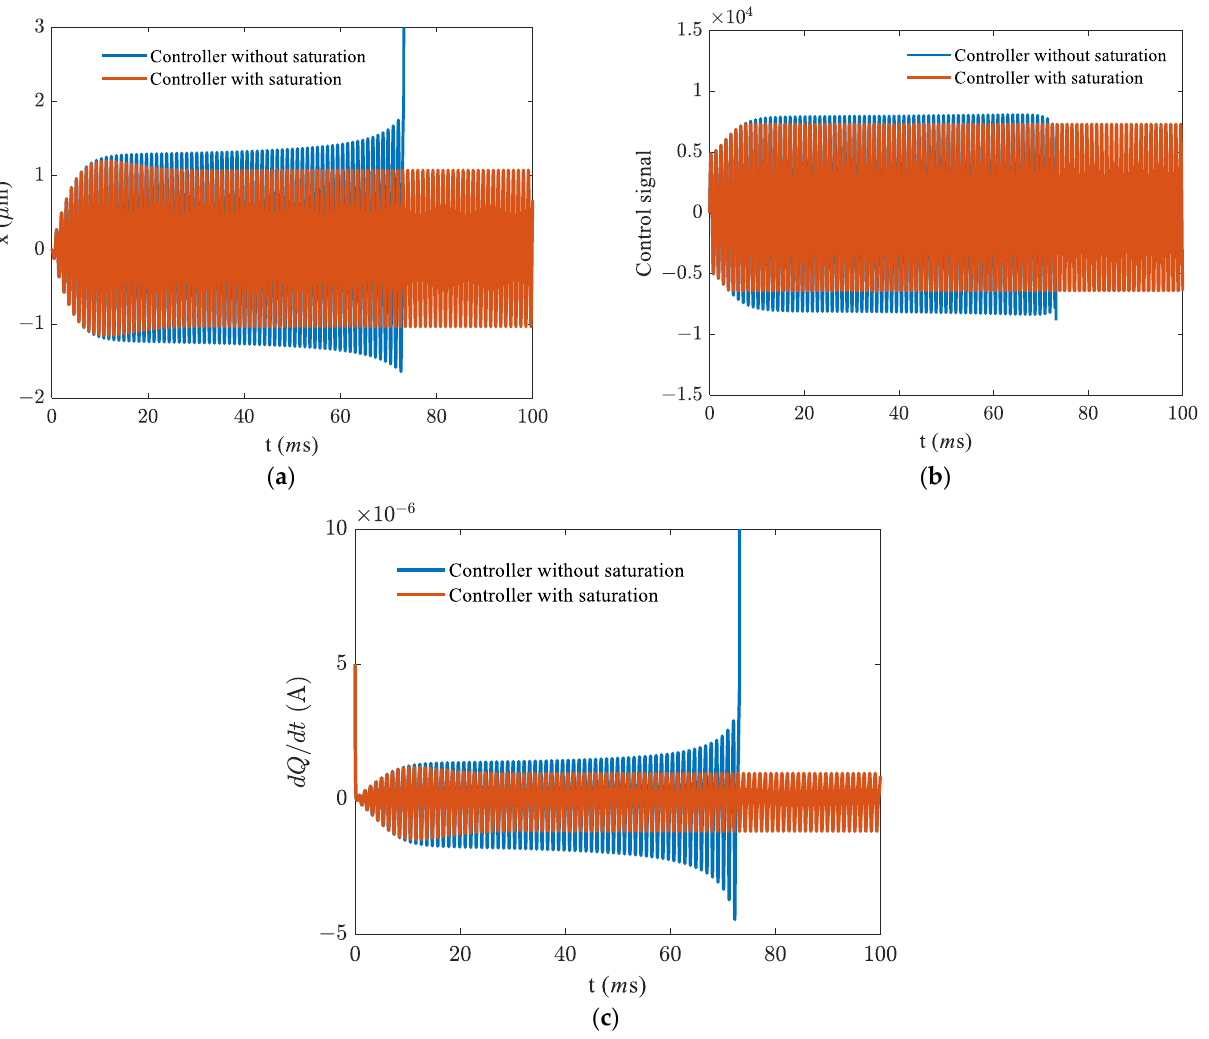
Figure 5. The response in the presence and absence of the saturation in the PID controller. ( a ) Time response, ( b ) feedback signal, and ( c ) current .